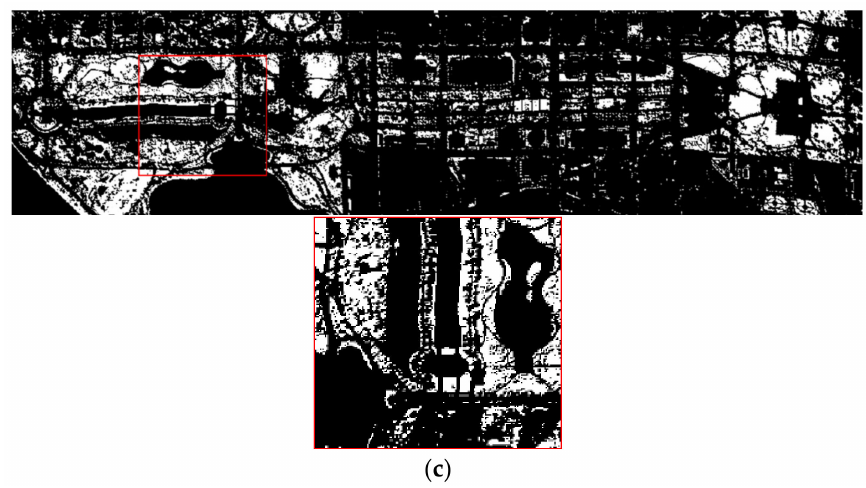
Figure 8. Extraction results of vegetation and partial enlarged image: ( a ) Ground truth information; ( b ) NDVI extraction result; ( c ) BAND41 extraction result.